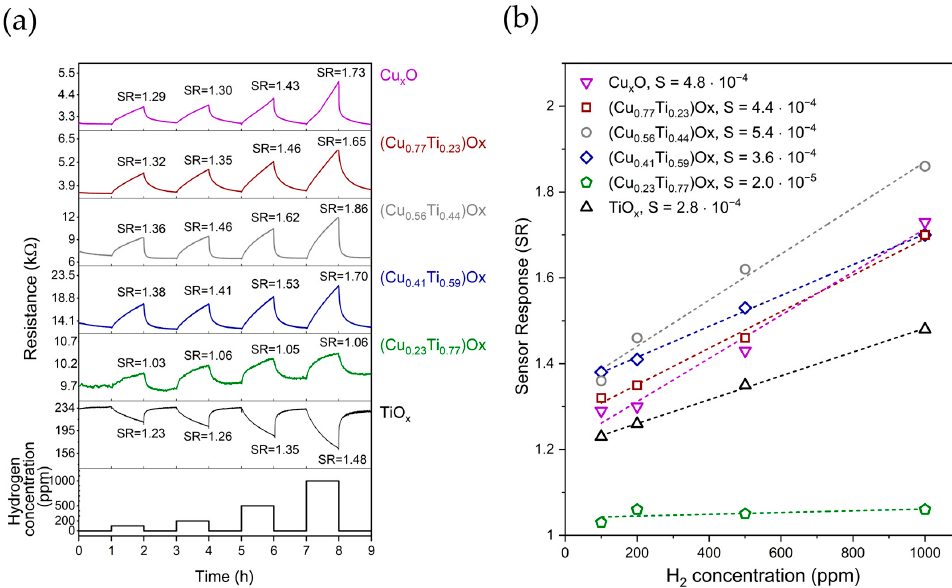
Figure 4. ( a ) Changes in electrical resistance of TiO x , (CuTi)Ox, and Cu x O thin fi lms annealed at 473 K upon exposure to 100–1000 ppm of H 2 ; ( b ) the sensor response as a function of hydrogen concen- tration.